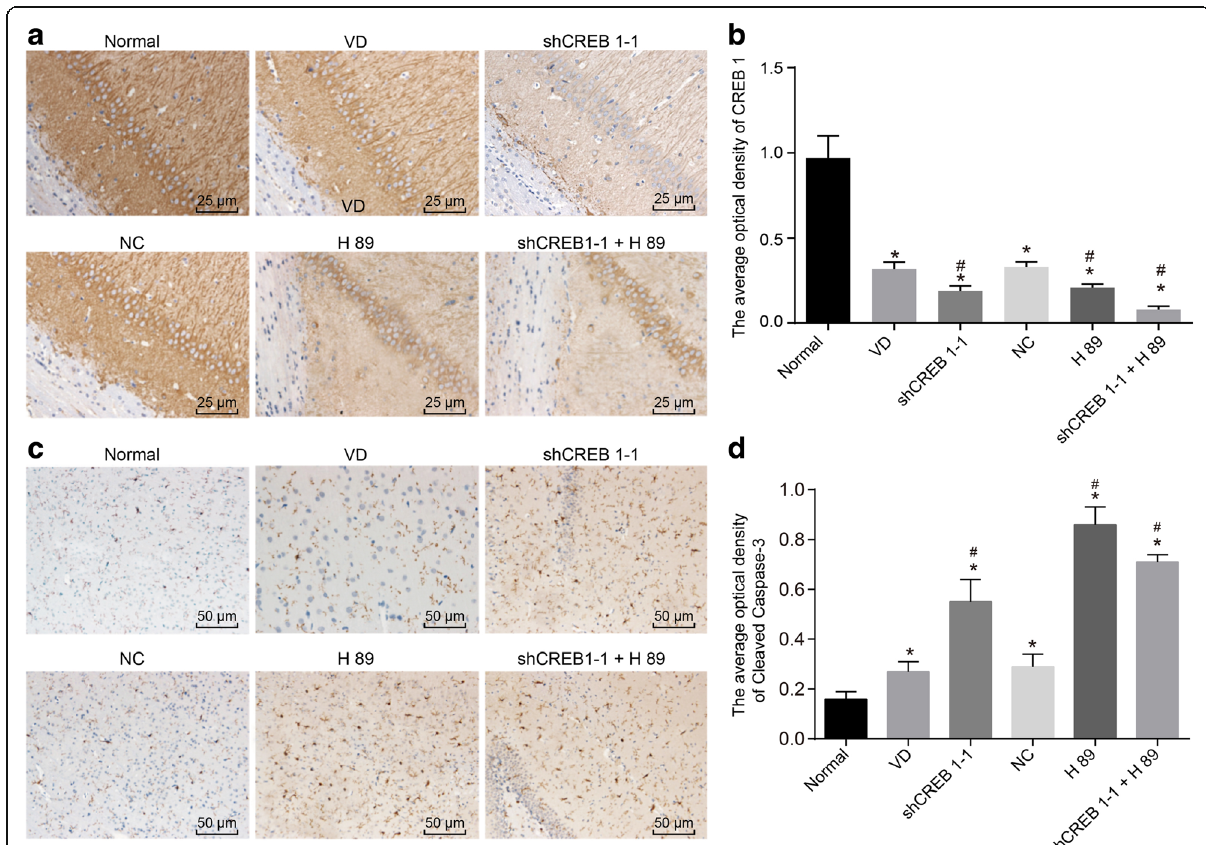
Fig. 4 Decreased positive expression rate of CREB1 and increased Cleaved Caspase-3 in the hippocampal CA1 area of mice injected with shCREB1 – 1 or/and H89, Notes: A, the immunohistochemical staining results of CREB1 in each group (× 200); B, the histogram of the CREB1 aver- age OD; C, the immunohistochemical staining results of Cleaved Caspase-3 in each group (× 200); D, the histogram of the Cleaved Caspase-3 average OD; * , p < 0.05, compared with the normal group; # , p < 0.05, compared with the VD group; CREB1, cyclic adenosine monophosphate